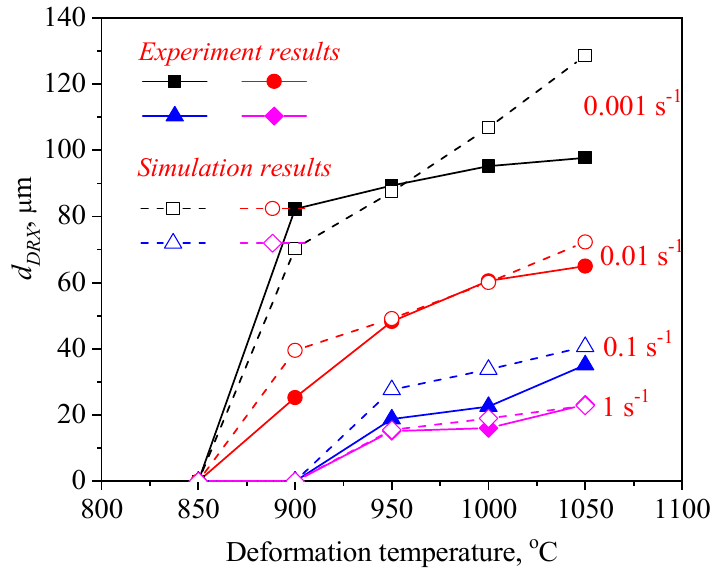
Figure 11. A comparison between the experimental and FE results of the grain size of recrystallized grains ( d DRX ).